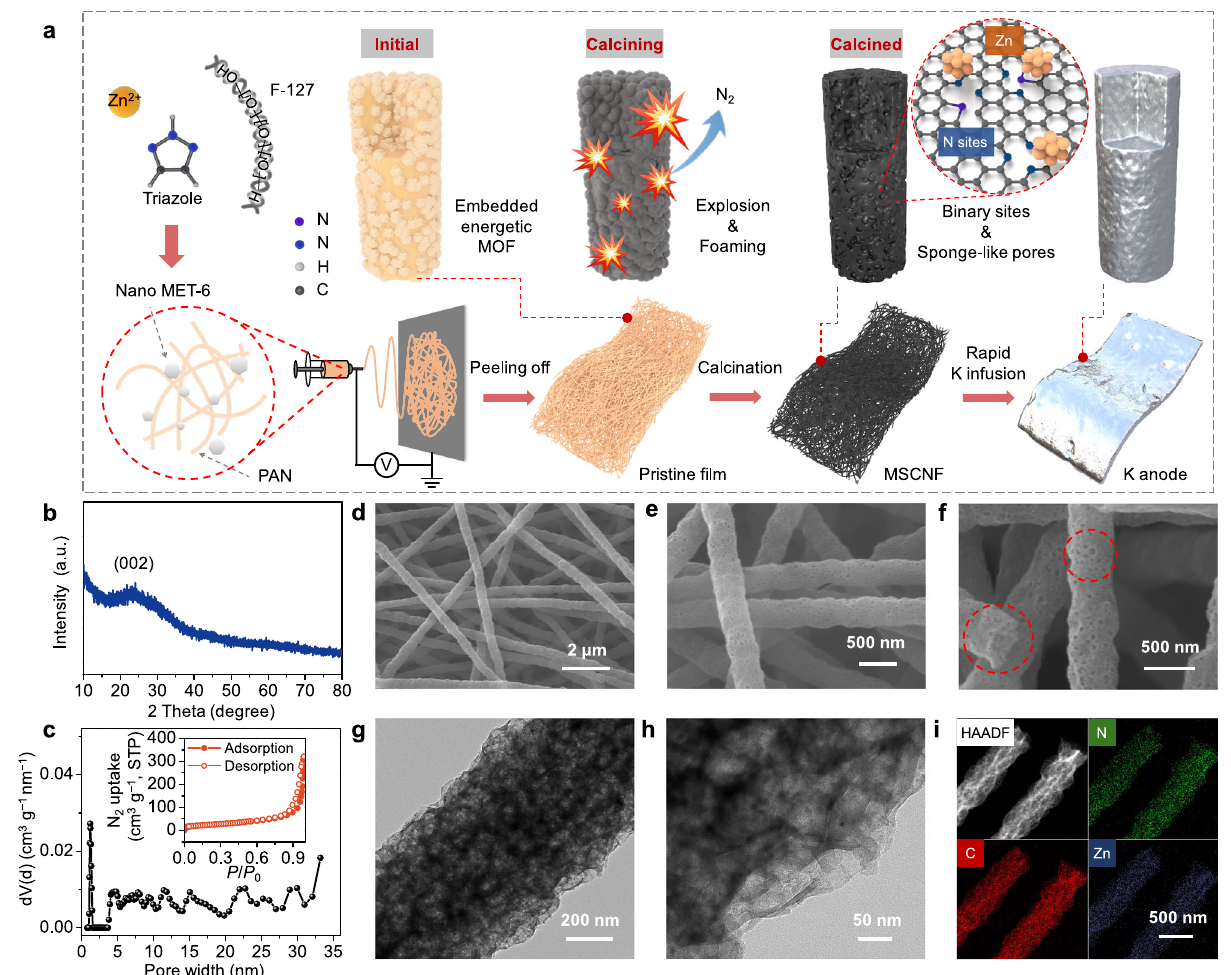
Fig. 1 | Synthesis and physicochemical characterization ofMSCNFs. a Synthetic route of MSCNFs and the corresponding composite K anode. b PXRD patterns of MSCNFs. c PoredistributionofMSCNFsandthecorrespondingN 2 − 77Kadsorption